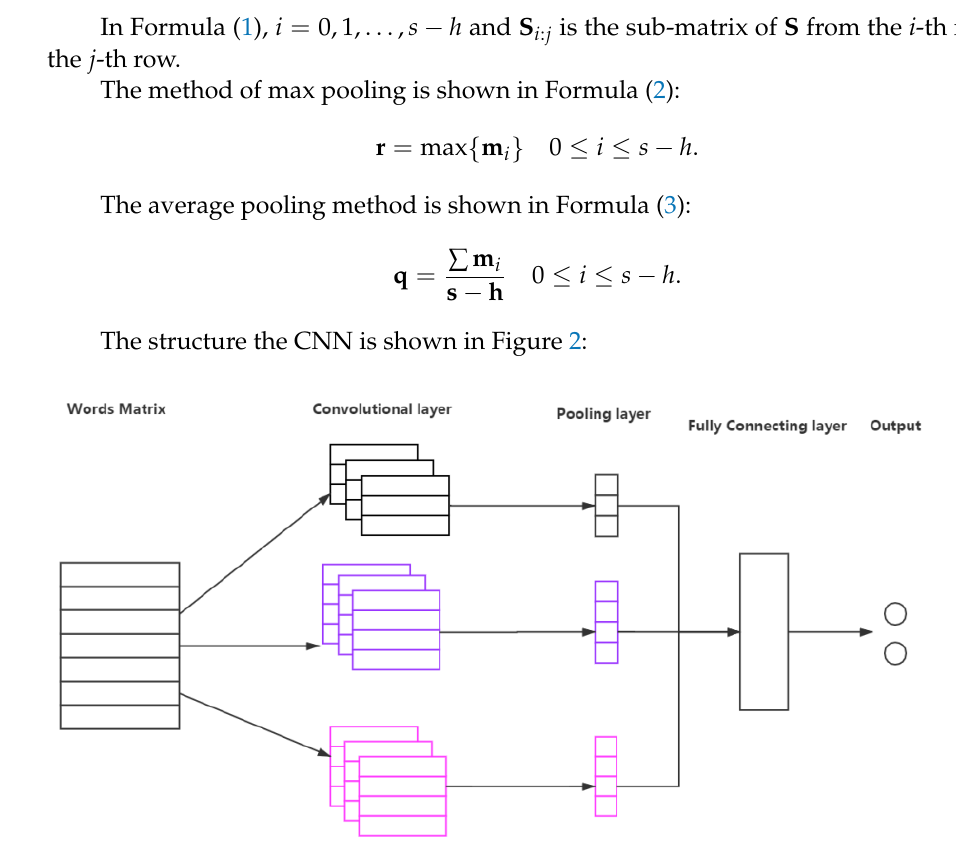
Figure 2. Convolutional neural network